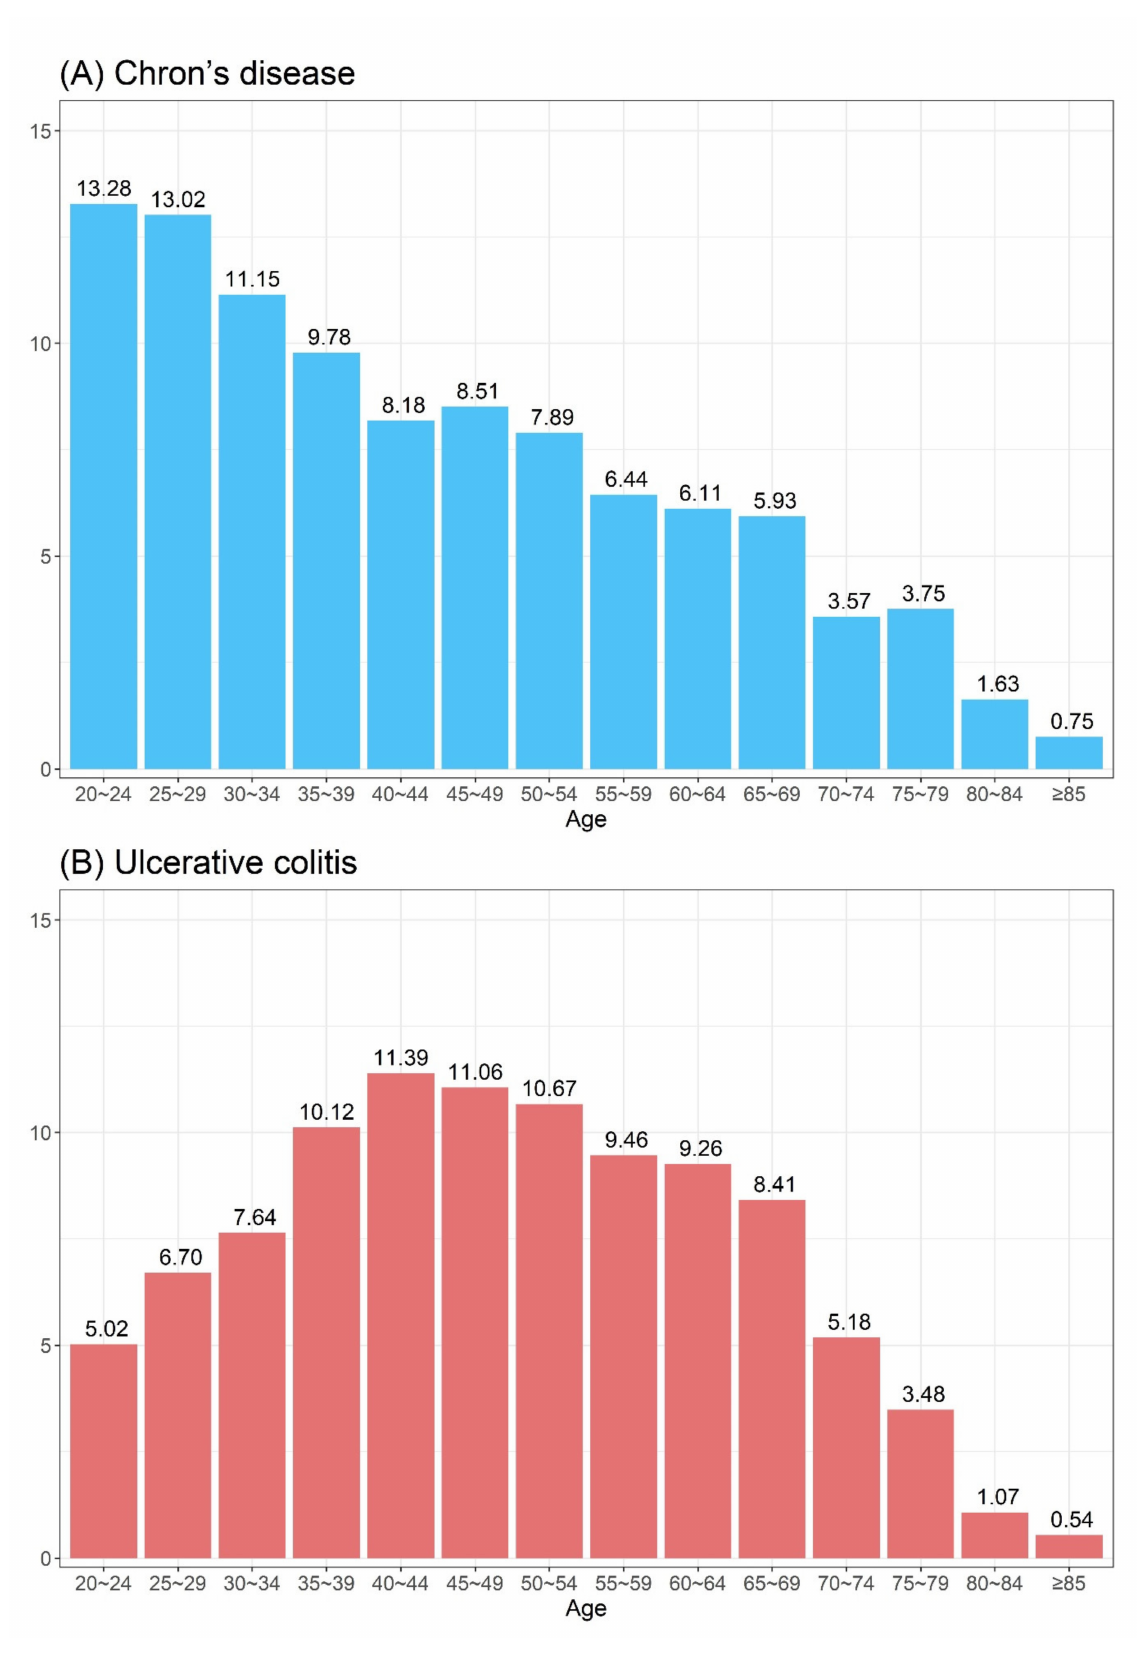
Figure 4. Age distribution of patients with ( A ) Crohn’s disease and ( B ) ulcerative